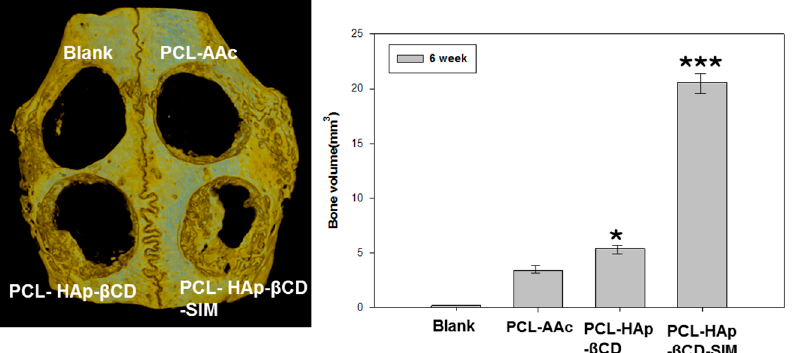
Figure 6. Micro-computerized tomography ( μ CT) scan images of rabbit calvarial defects after 6 weeks of implantation of various poly( ɛ -caprolactone) (PCL) scaffolds. * p < 0.05 and *** p < 0.005 compared to the PCL-AAc group.